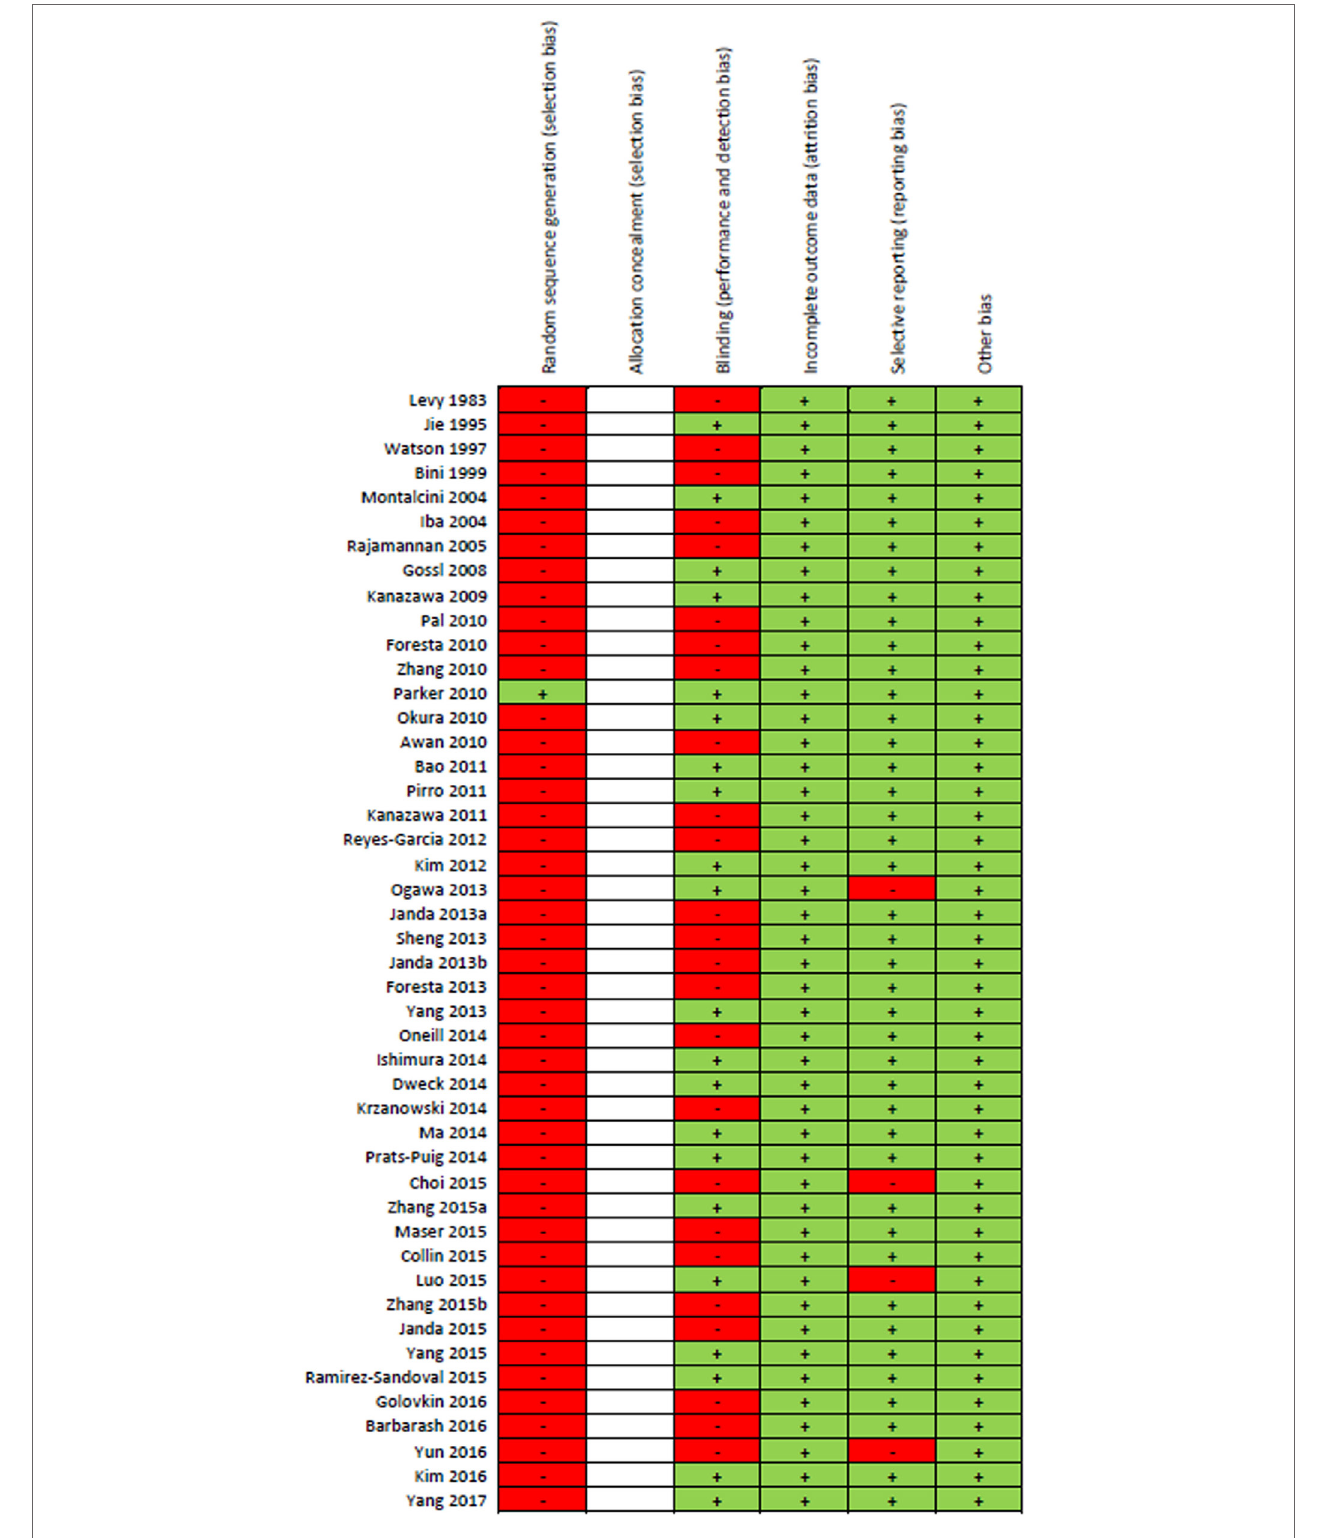
FigURe 2 | “Risk of bias” summary: green (+) indicates low-bias risk and red ( – ) indicates high-bias risk. The studies included in this review were all observational in study design and thus the risk of bias for the item “allocation concealment” was not performed and spaces were left